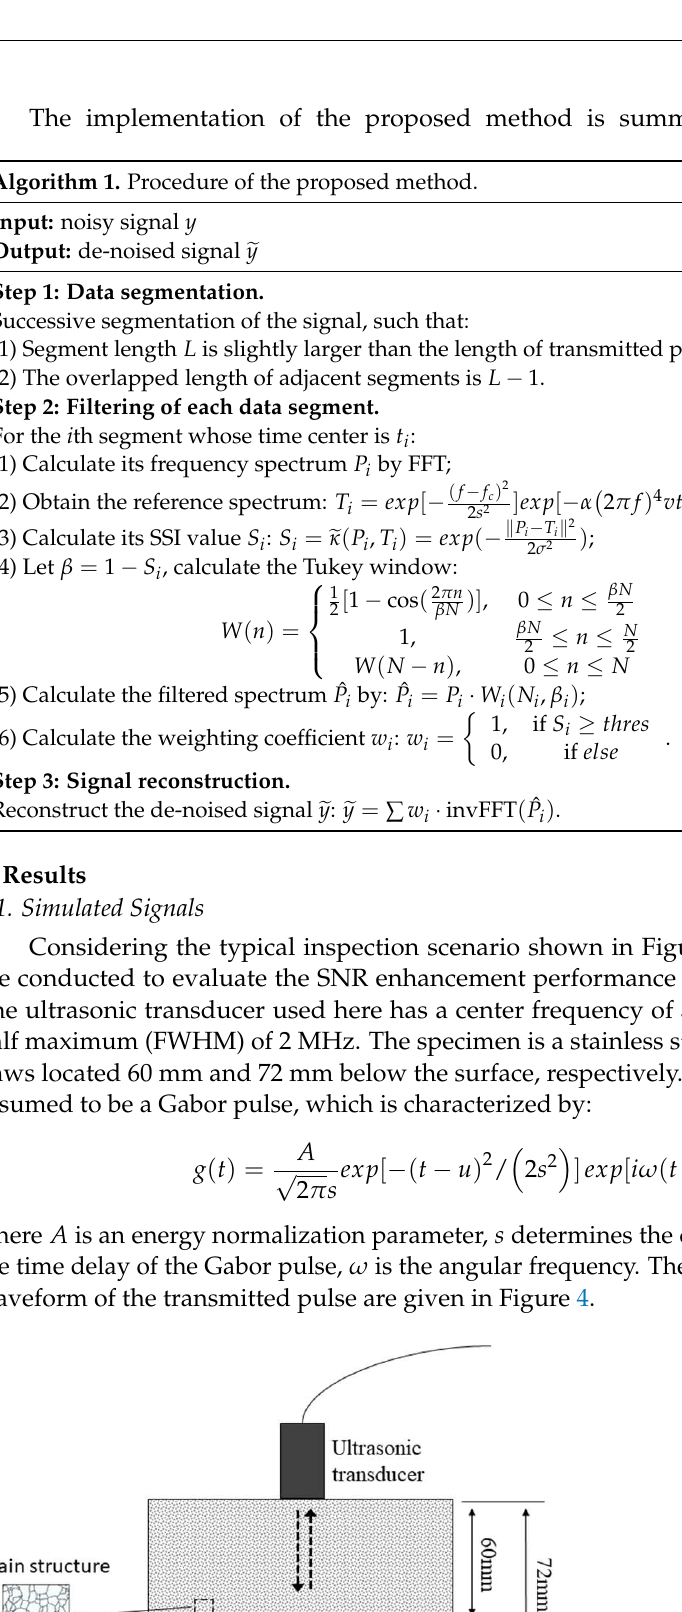
7 of 14 Algorithm 1. Procedure of the proposed method. Input: noisy signal